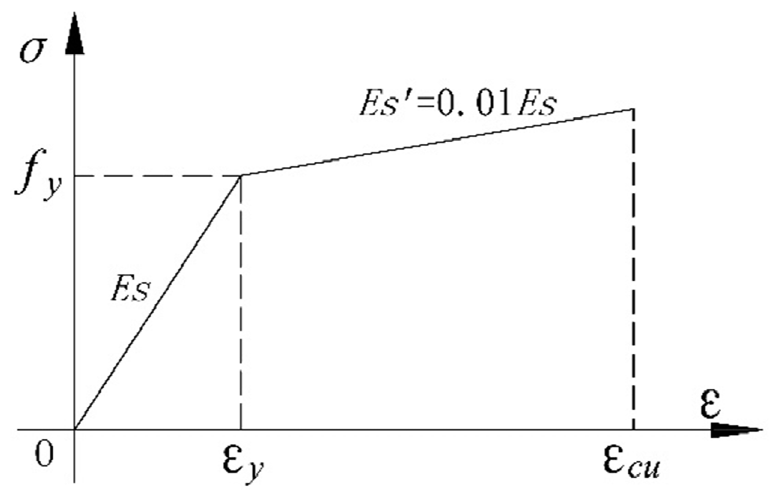
Figure 20. Bilinear stress–strain curves for steel.